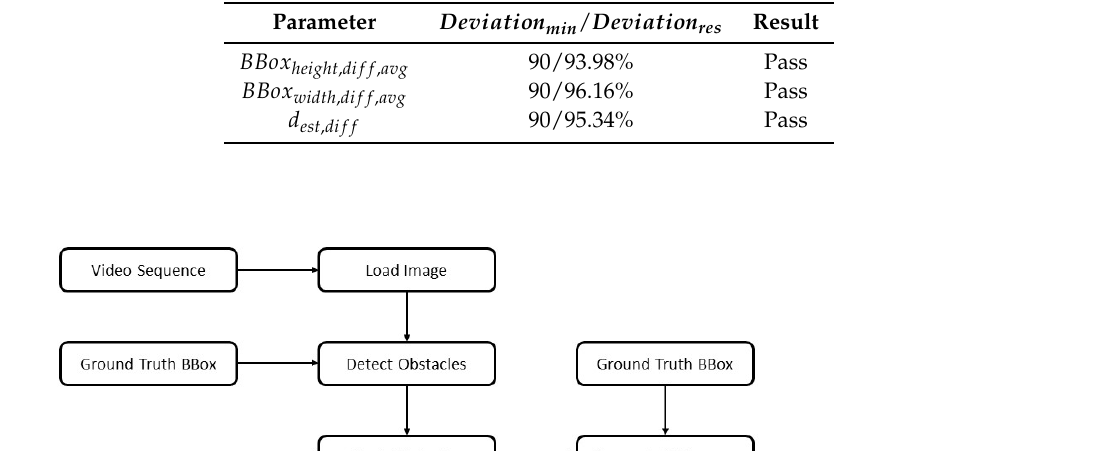
Table 7. Minimum validation criteria and experimental results.